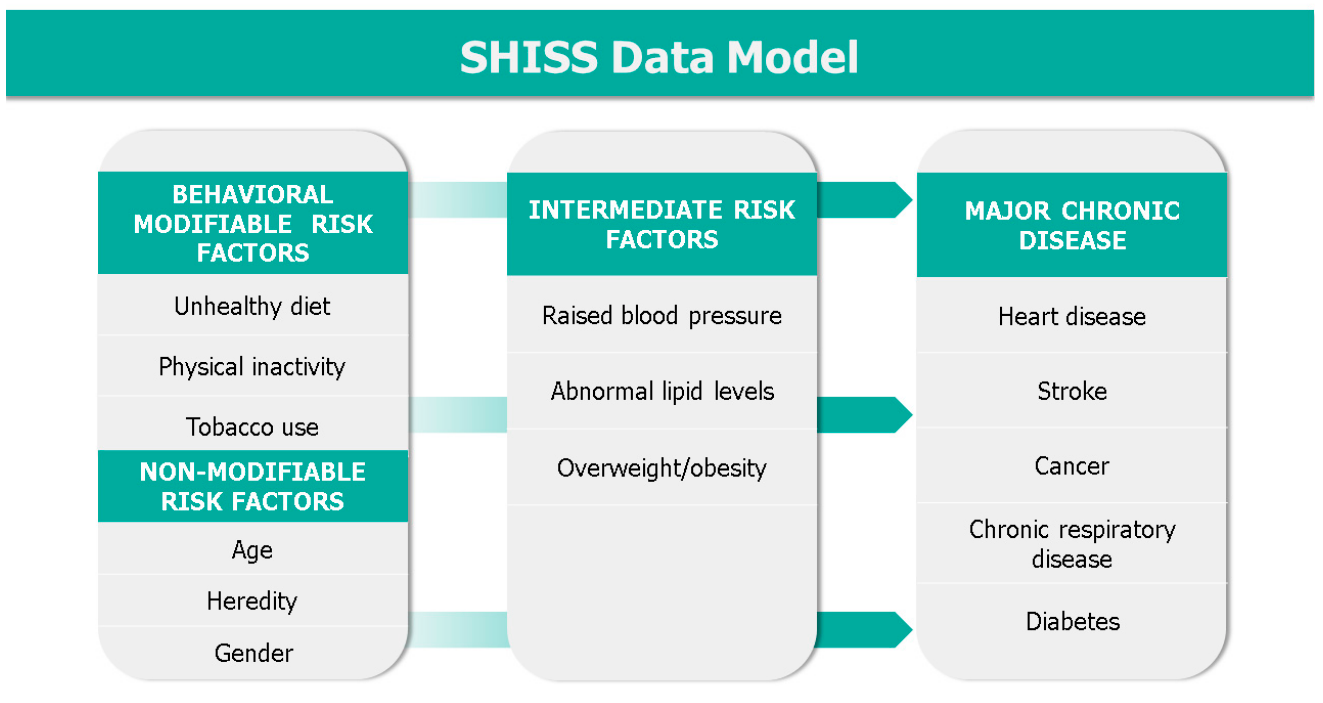
Figure 1. The Sharik Health Indicators Surveillance System (SHISS) data model.